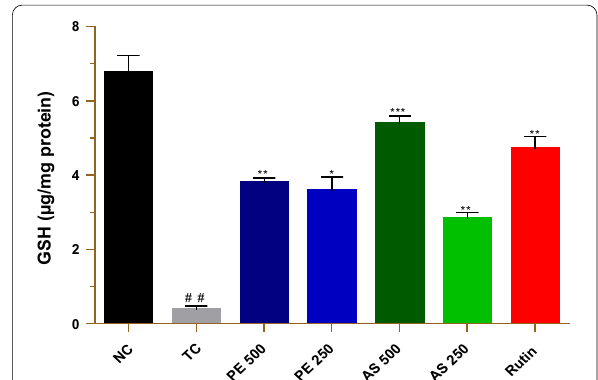
Fig. 7 Effect of P. erinaceus and A. spinosus on GSH levels in kidney fragments. NC normal control under 5 mM glucose; TC toxic = = control under 30 mM glucose; PE and AS 500; 250 P. erinaceus and = A. spinosus at doses of 500 and 250 mg/kg bw 30 mM glucose; + Rutin rutin at a dose of 500 µg/kg bw 30 mM glucose. The = + values were analyzed with a one‑way ANOVA and then expressed as mean SEM. ## p < 0.01 compared to NC; * p < 0.05; ** p < 0.01; ± *** p < 0.001; compared to TC. n =